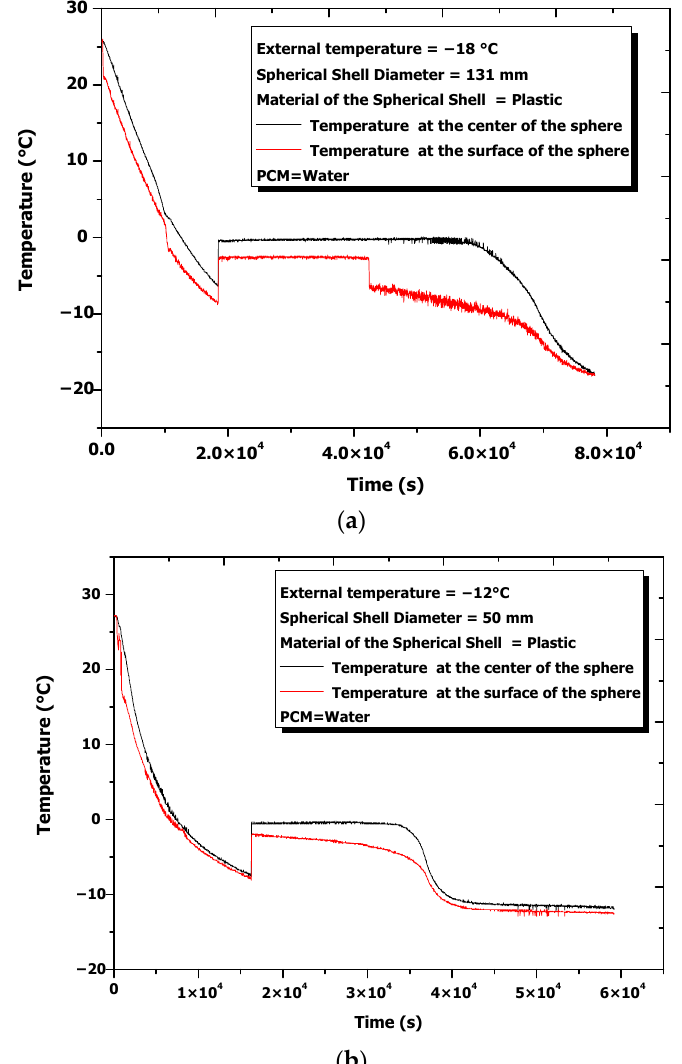
Figure 9. Temperature change in the center of the plastic spherical capsule during solidification of water